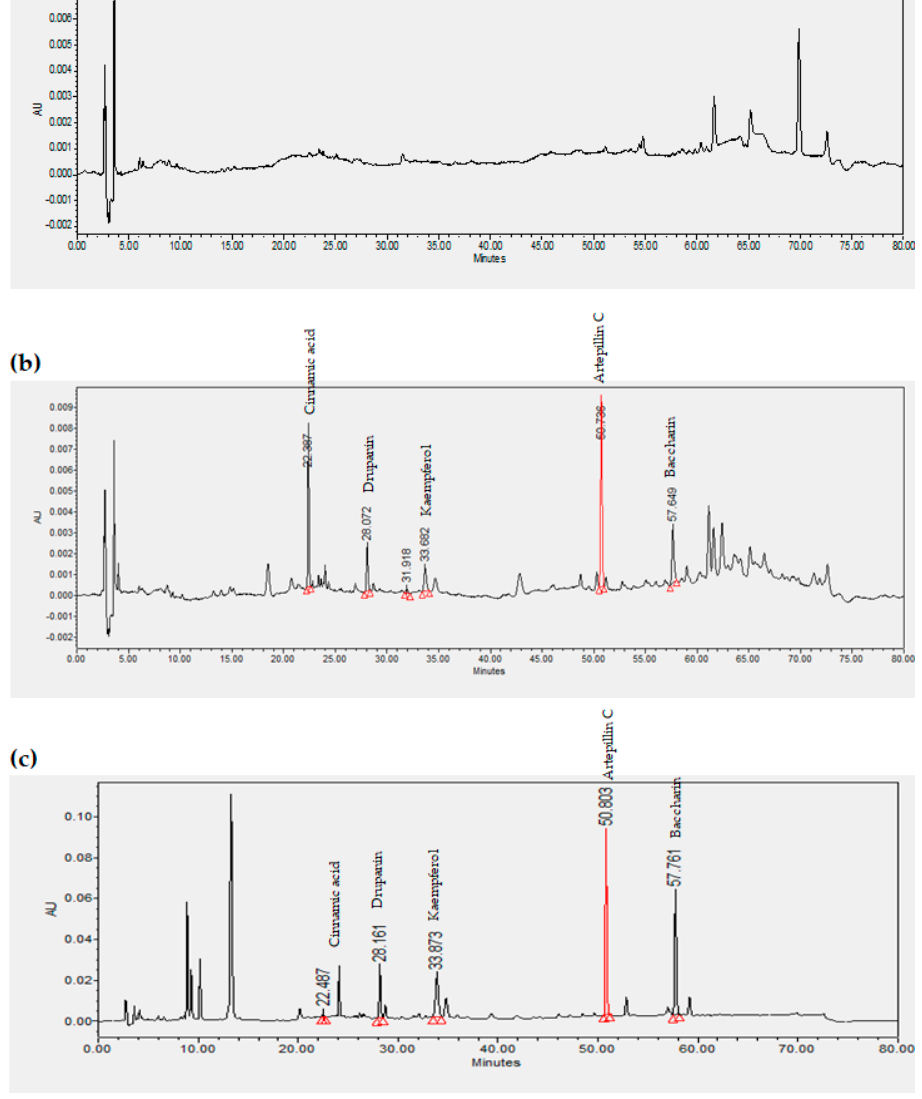
Figure 1. Chromatogram of concentrated methanol extract of ( a ) purified beeswax, ( b ) raw beeswax, and ( c ) green propolis. Chromatographic conditions: C18 column with a mobile phase composed of (A) water containing 0.4% formic acid, 5% methanol, and 2% isopropanol, and (B) acetonitrile and 2% isopropanol. The flow was 1 mL/min in the concentration gradient, using 20% B for 3 min, 20–25% B for 3–4 min, 25% B for 4–15 min, 25–45% B for 15–20 min, 45% B for 20–40 min, 45–60% B for 40–45 min, 60–80% B for 45–68.83 min, 80–20% B for 68.86–70 min, and 20% B for 70–80 min. An injection volume of 15 μ L, oven temperature of 30 °C, and wavelength of 300 nm were used.